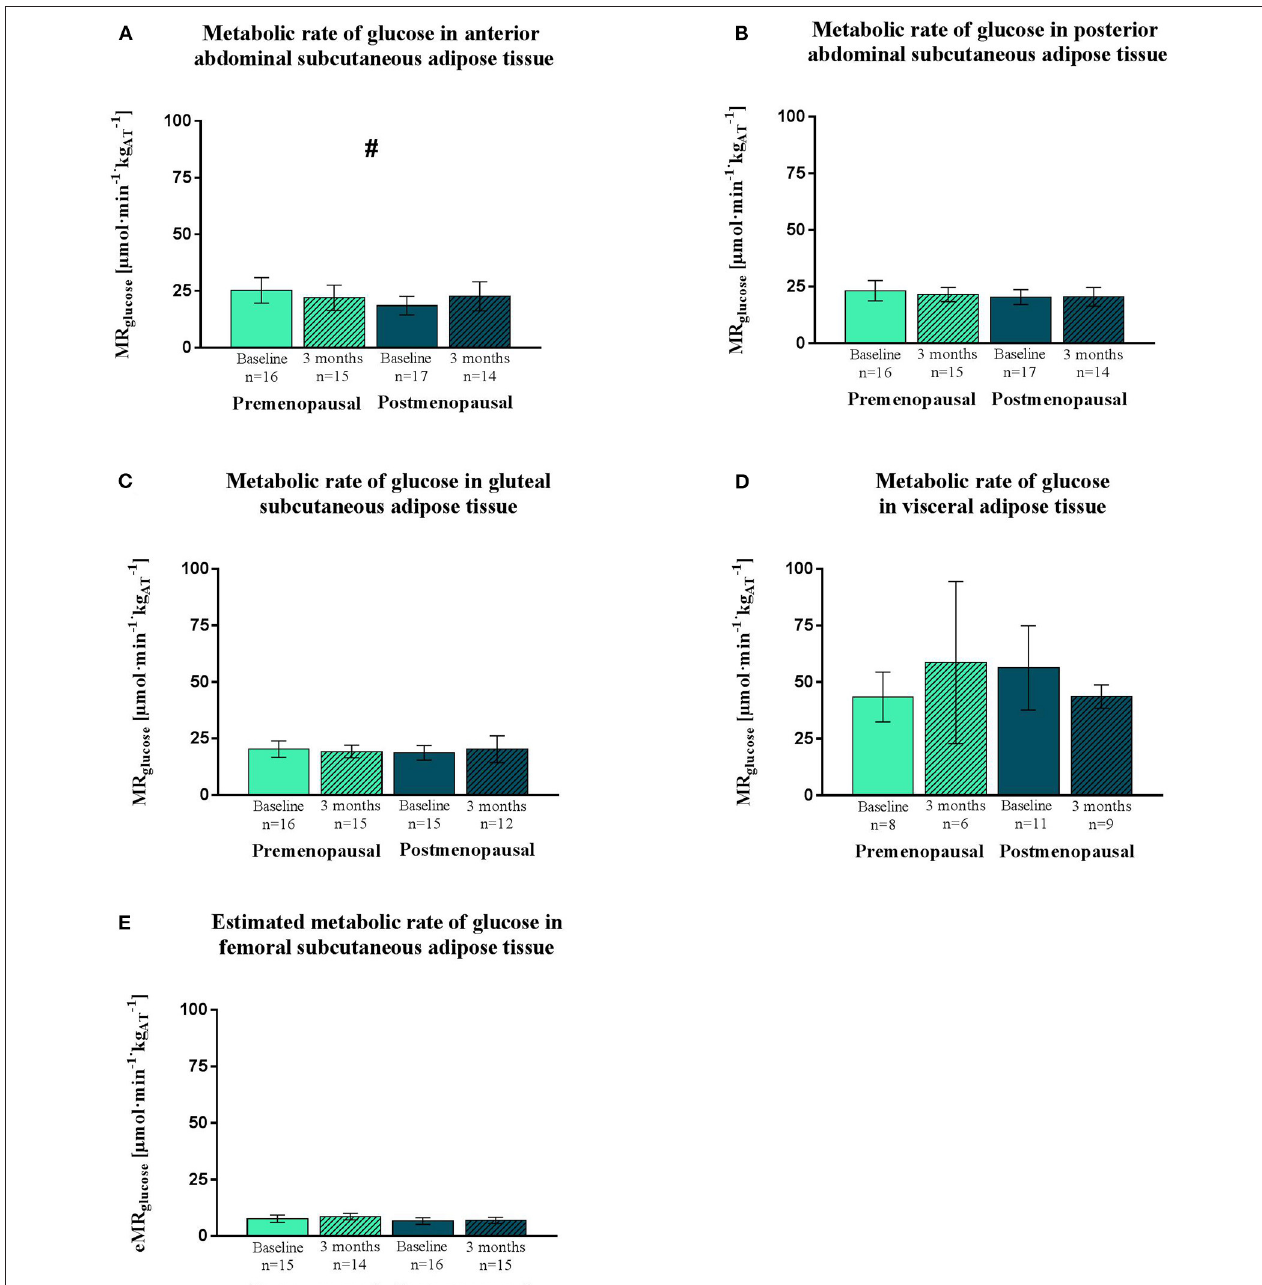
FIGURE 2 | Insulin-stimulated glucose uptake in adipose tissue, expressed as MR glucose . PET/CT-derived data of MR glucose of abdominal subcutaneous (anterior and posterior), visceral and gluteal adipose tissue. Estimated MR glucose of femoral subcutaneous adipose tissue. Data was obtained during a hyperinsulinemic euglycemic clamp in pre- and post-menopausal women before and after 3 months of high-intensity training. Data are presented as mean (95% confidence limits). MR glucose is higher in visceral than subcutaneous adipose tissue depots. Interaction between groups and time # p ≤ 0.05. MR glucose , Metabolic rate of glucose. (A) Metabolic rate of glucose in anterior abdominal subcutaneous adipose tissue. (B) Metabolic rate of glucose in posterior abdominal subcutaneous adipose tissue. (C) Metabolic rate of glucose in gluteal subcutaneous adipose tissue. (D) Metabolic rate of glucose in visceral adipose tissue. (E) Estimated metabolic rate of glucose in femoral subcutaneous adipose